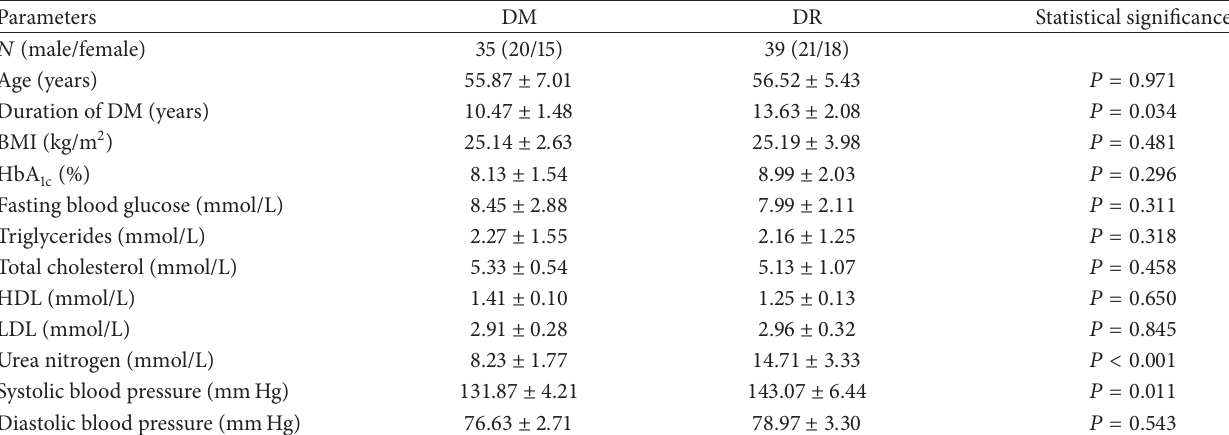
Table 1: Clinical and biochemical parameters of diabetic patients with retinopathy (DR) and without retinopathy (DM).